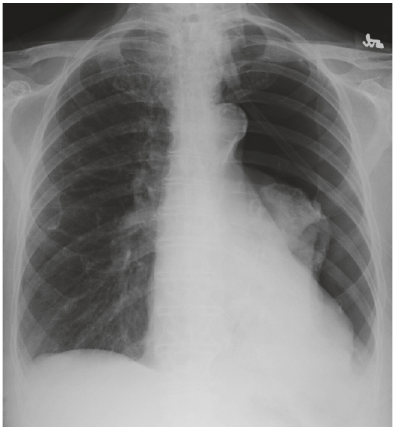
Figure 1: Initial portable chest X-ray showing significant left lung collapse.